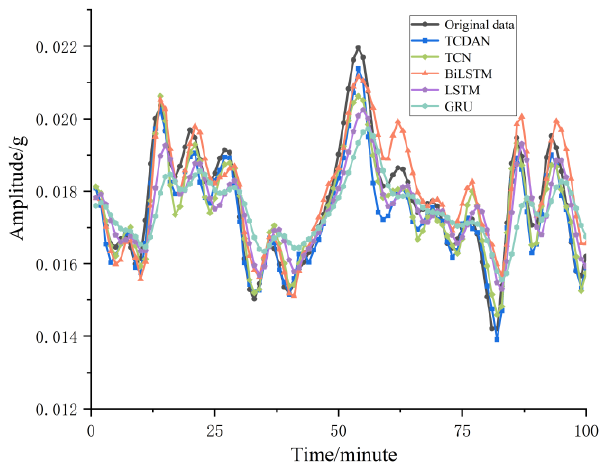
Figure 12. Prediction comparison of the amplitude corresponding to 1 × fo.